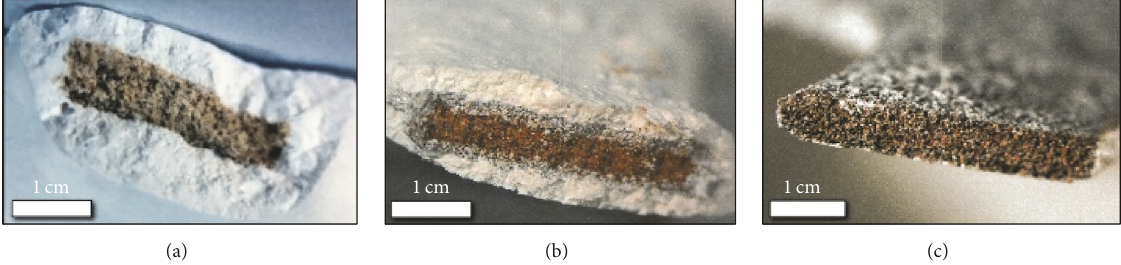
Figure6:Opticalimagesofimpregnated3DstructureswithdispersionsofAl 2 O 3 ,usinganAl 2 O 3 concentrationof(a)0.77 g/ml,(b)0.65 g/ml, and (c) 0.47